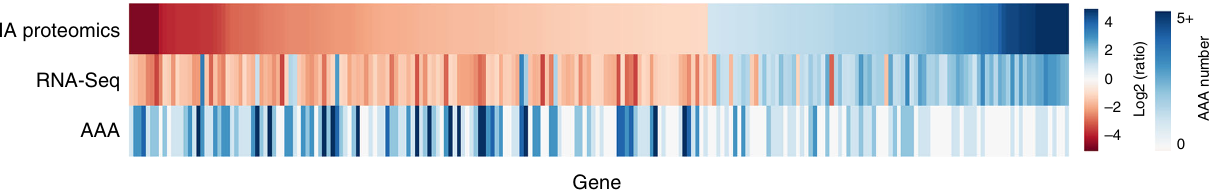
Fig. 7 mRNA levels correlate with protein expression. Heatmaps comparing fold changes in newly synthesized proteins (AHA-labeling Proteomics, top row) and mRNA levels (RNA-Seq, middle row) in ±MazF-mt9 cultures. Genes with at least a log2ratio of ±1 were considered. The number of AAA codons (bottom row) of each gene is shown. Source data are provided as a tab within the Source Data fi le